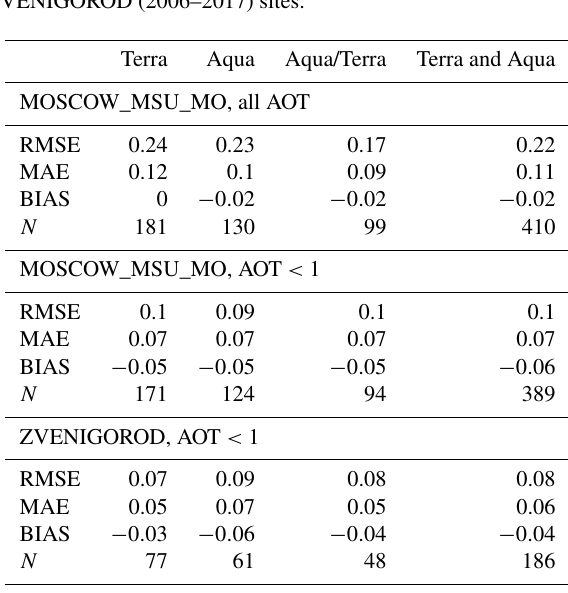
Table 1. Statistical estimates of the uncertainties in AOT MAIAC retrievals for the Terra and Aqua data separately, for the Terra and Aqua measurements within 1h (Aqua/Terra), and together for the data from the two satellites (Terra and Aqua) against ground-based AERONET data at the MOSCOW_MO_MSU (2001–2017) and ZVENIGOROD (2006–2017)